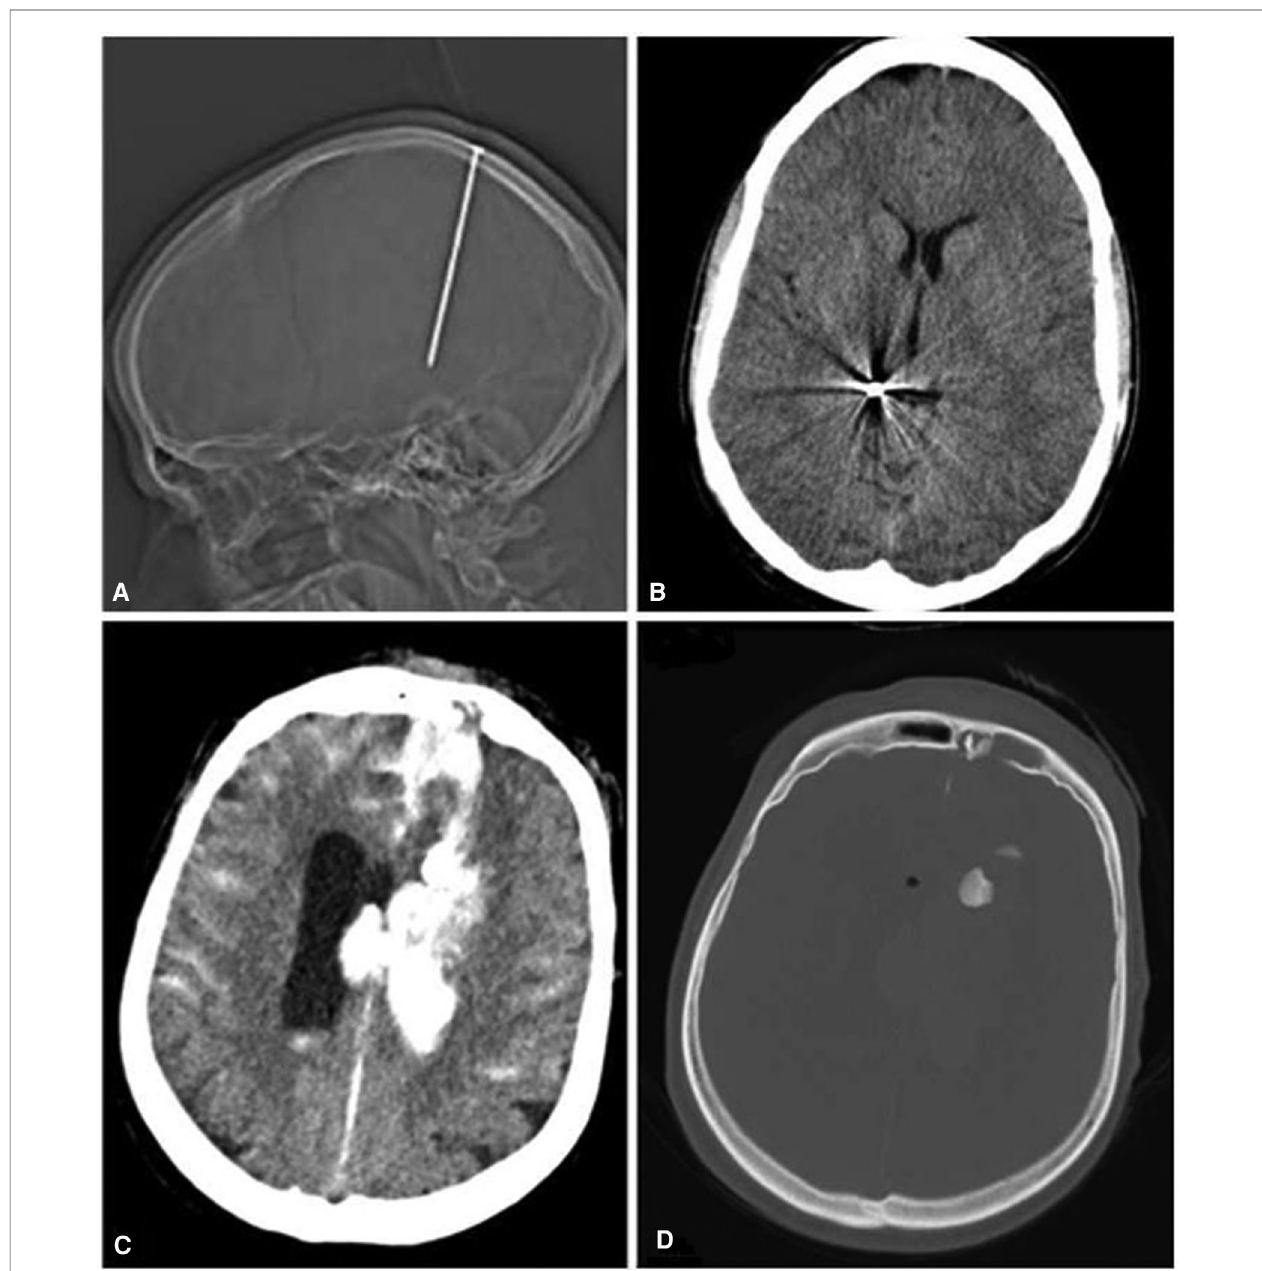
metallic fragments or exit sites (19 –